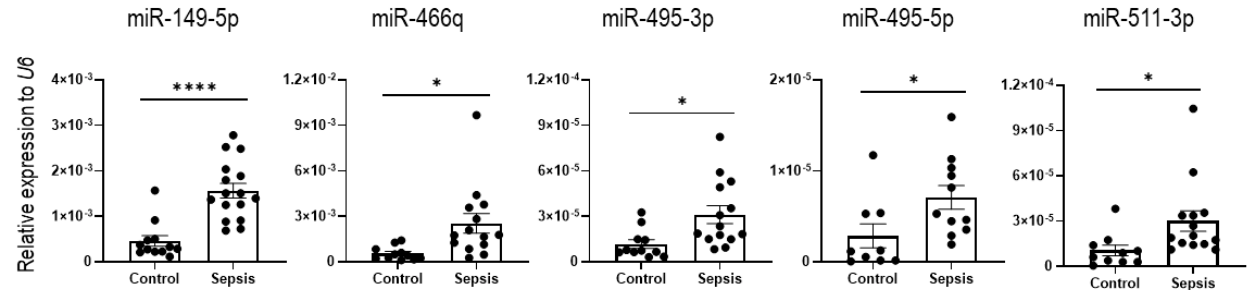
Figure 5. Validation of identified candidate miRNAs upregulated in sepsis IECs. The expression of upregulated miRNAs (miR-149-5p, miR-466q, miR-495-3p, miR-495-5p, and miR-511-3p) was tested using real-time quantitative PCR (RT-qPCR) analysis. U6 was used as an endogenous control to normalize miRNA expression levels. Data are shown as scatter plots and bars overlaid with the mean ± standard error of the mean (SEM). Dot on the plot represents the value of each mouse. Control and sepsis indicate the IECs isolated from sham and sepsis cohorts, respectively. * p < 0.05 and **** p < 0.0001.